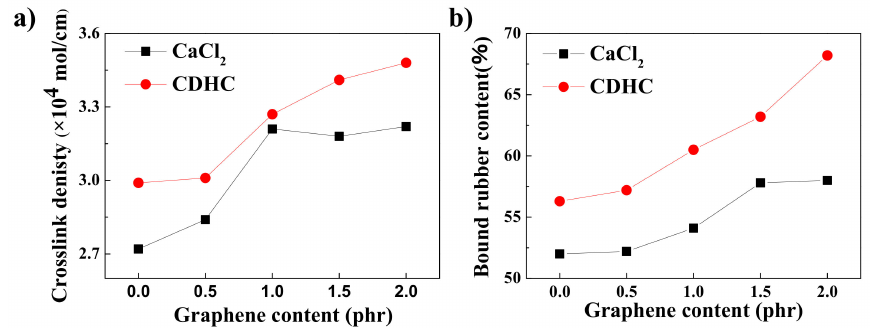
Figure 5. ( a ) Crosslinking density and ( b ) bound rubber content of di ff erent 60SiO 2 / rGO / NR composites, which were coagulated by CaCl 2 and